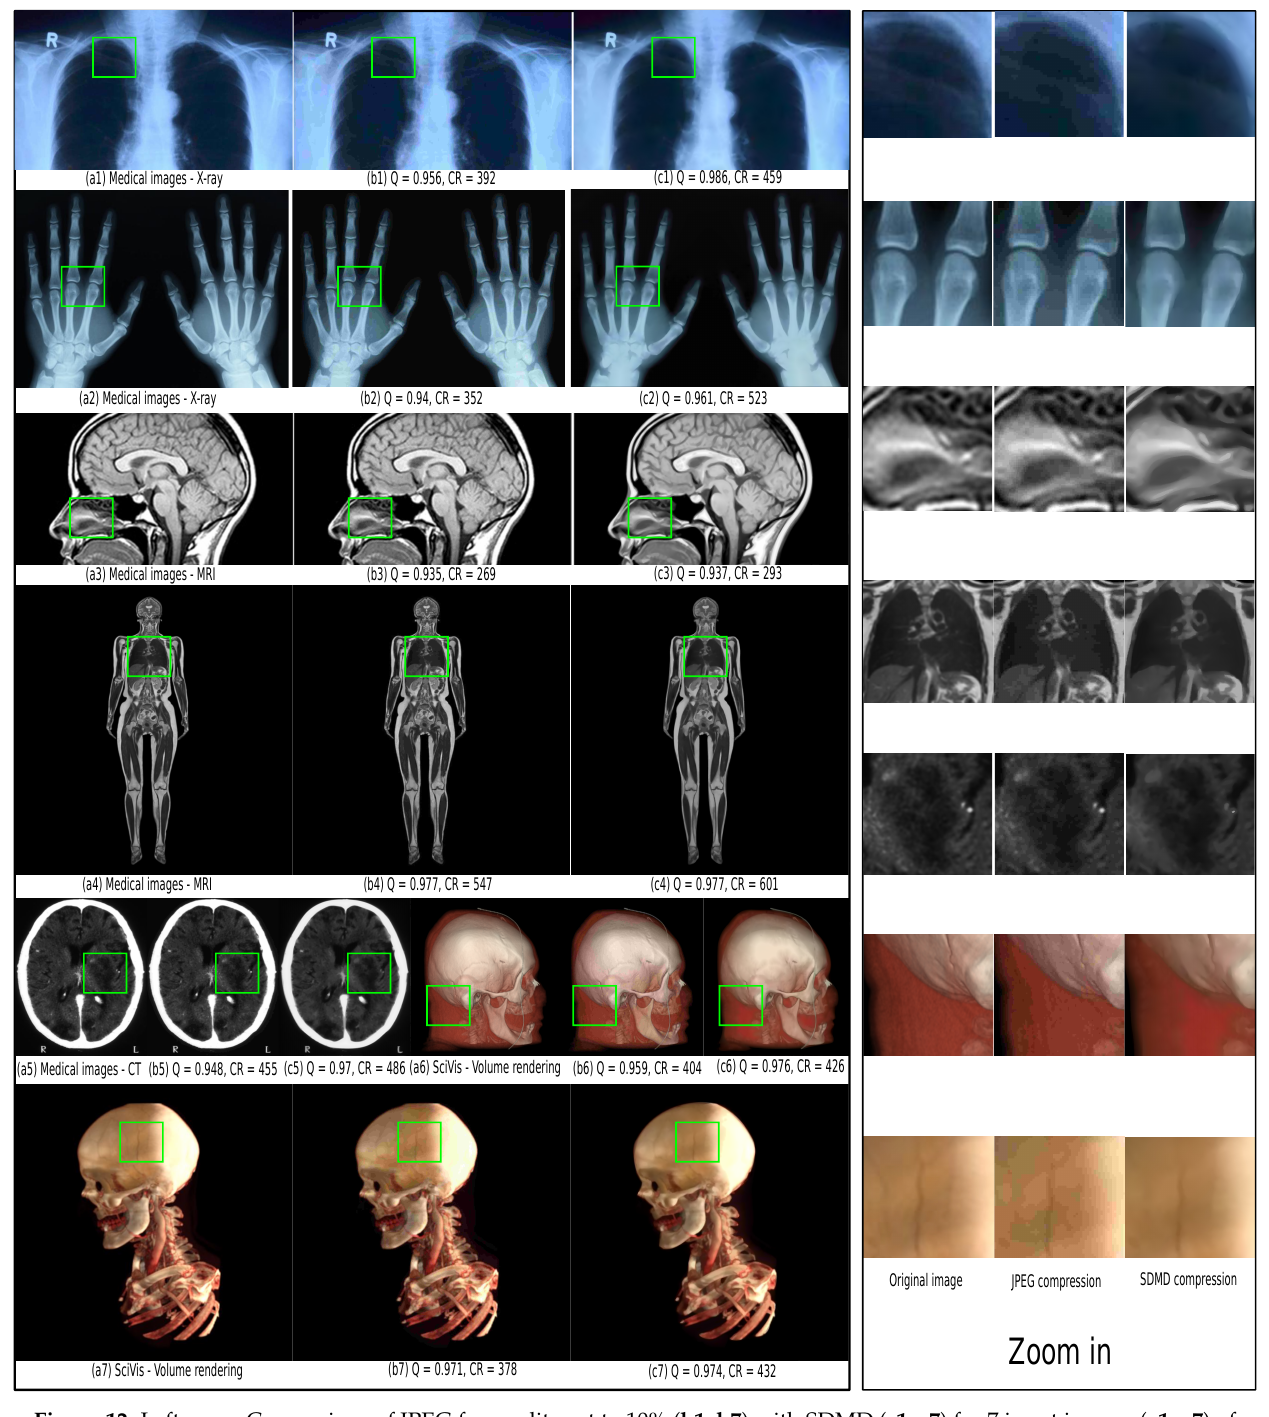
Figure 12. Left pane: Comparison of JPEG for quality set to 10% ( b1 – b7 ) with SDMD ( c1 – c7 ) for 7 input images ( a1 – a7 ) of medical type. For each result, we show the SSIM quality Q and the compression ratio CR. Right pane: Zoomed-in areas, marked in green in the images in the left pane, show subtle differences between the original, JPEG, and